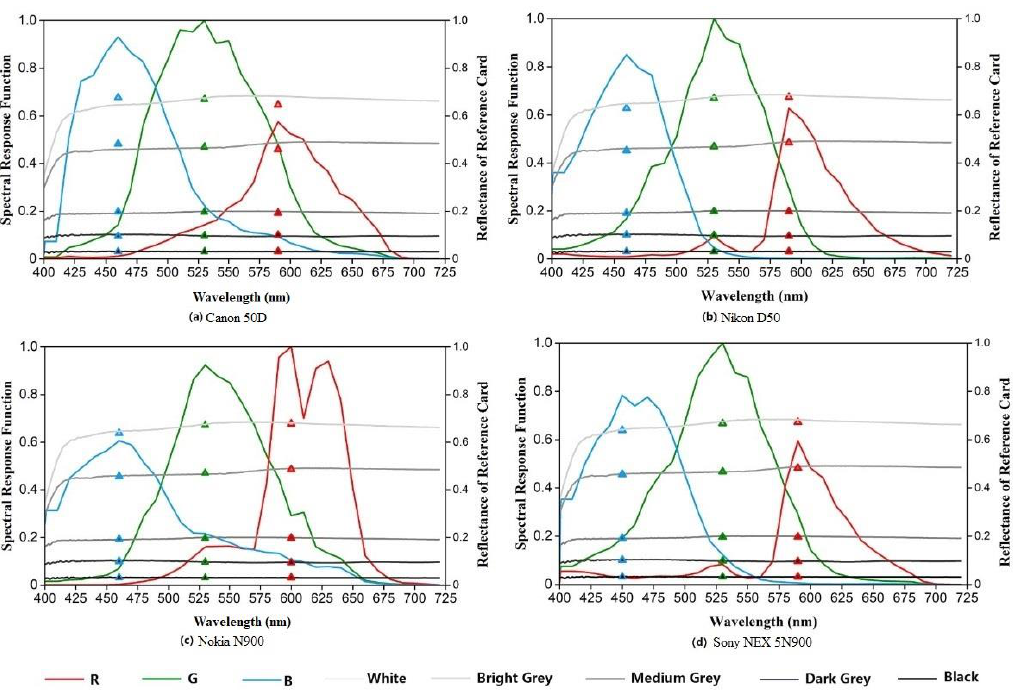
Figure 9. Spectral response functions of four cameras [21]. ( a – d ) showing the RGB bands (red, green, and blue curves), the reflectance curves of the five-color reference cards (white, bright gray, medium gray, dark gray, and black curves), and the results of the equivalent reflectance of the reference cards in the Canon 50D RGB bands (triangles).